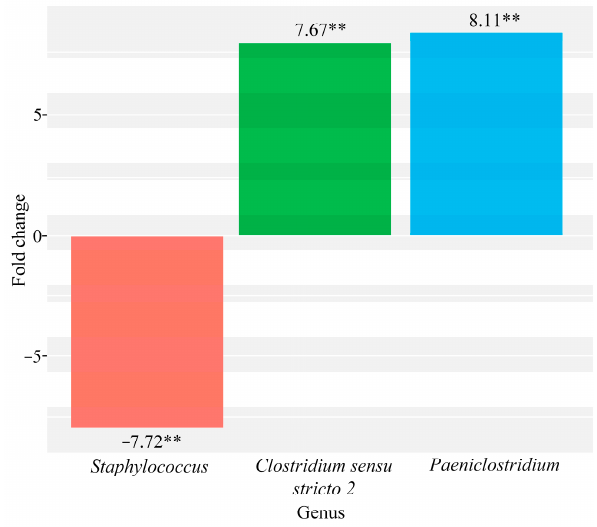
Figure 4. Quantitative changes in the general microbiome composition of milk samples taken from cows with acute catarrhal mastitis compared to the group with udder irritation ( ∗∗ p ≤ 0.001). Additionally, microbiome differences have been observed between groups with subclinical mastitis and acute catarrhal mastitis, characterized by an increase in Staphy- lococcus of 8.05 times ( p = 0.0002) and Streptococcus of 4.54 times ( p = 2.97×10 − 6 ) in the sub- clinical mastitis group (Figure 5).